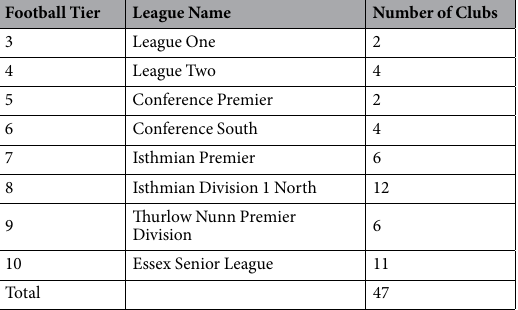
Table 1. Number of participating clubs from 8 football tiers in